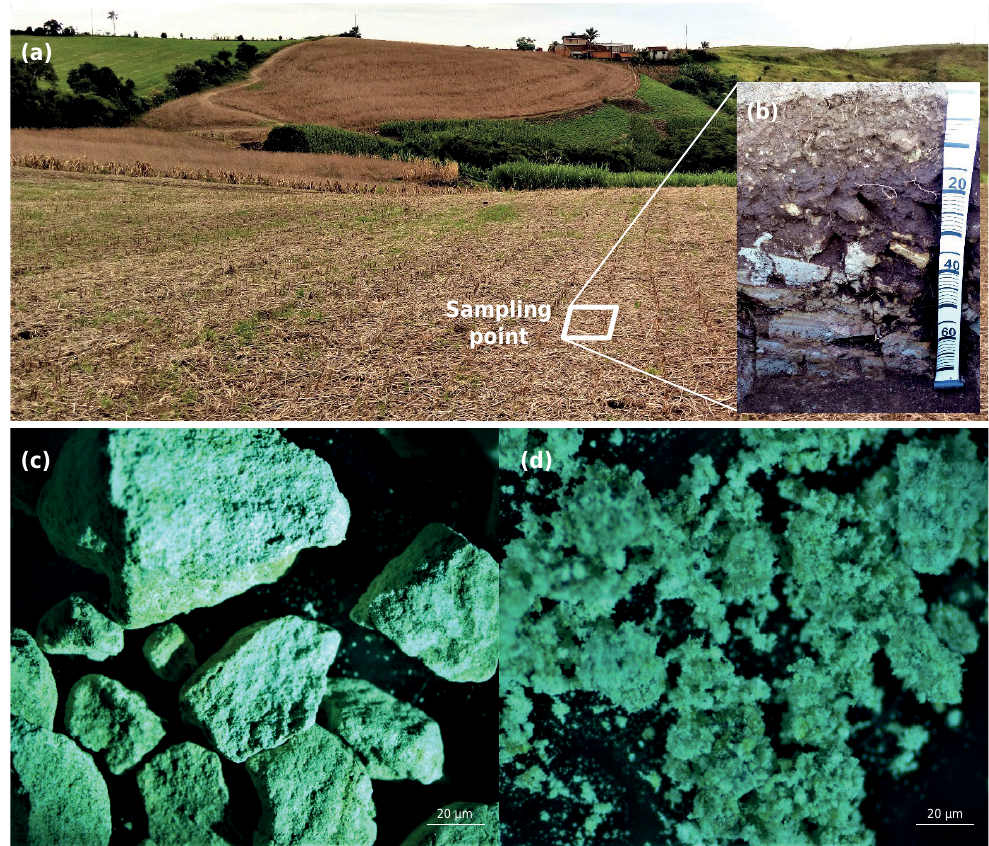
Figure 2. Typical relief of areas in the upper part of the transition from the central plain to the plateau of the state of Rio Grande do Sul, Brazil (a). Soil profile in the sampled location (b), stereo microscope images of saprolite fragments before (c), and after breakdown